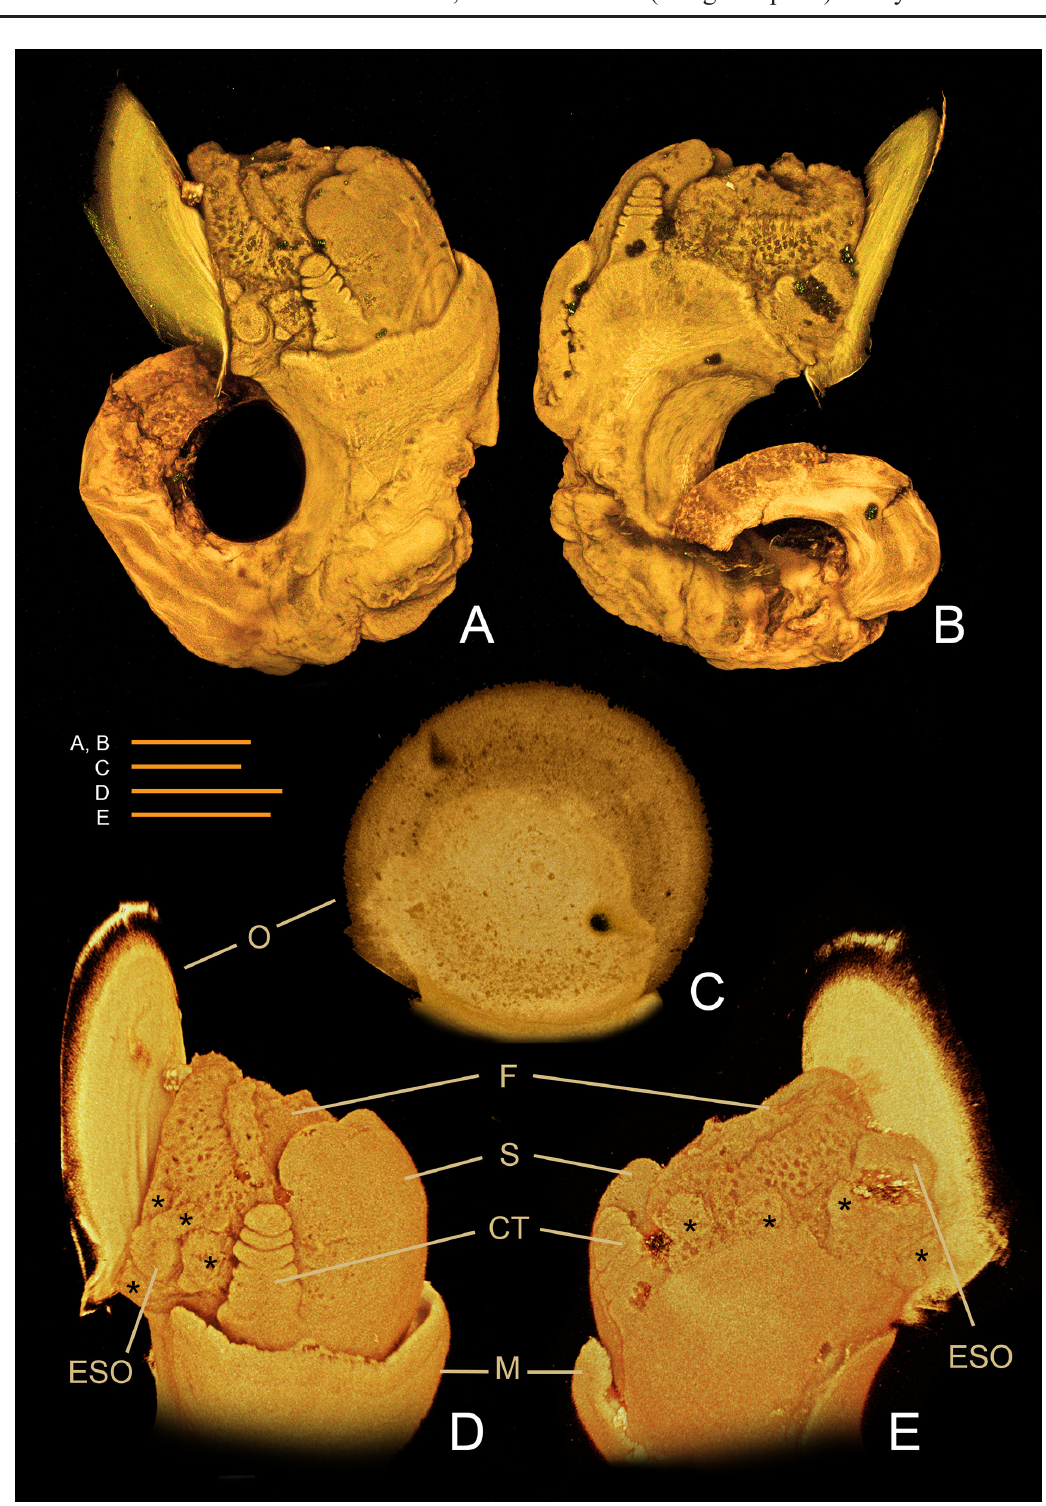
Fig. 9. CLSM images of contracted soft parts of Anatoma laevapex sp. nov., INDEX19_127RO (I19_ Ma_73). A–B . Complete soft parts in apical view (A) and basal view (B). C . External view of operculum. D . Left antero-dorsal view showing cephalic tentacle (CT), epipodial sensory organ (ESO), epipodial appendage (*), foot (F), operculum (O), mantle edge (M) and snout (S). E . Right view of anterior with same parts as in D. Scale bars: 0.5